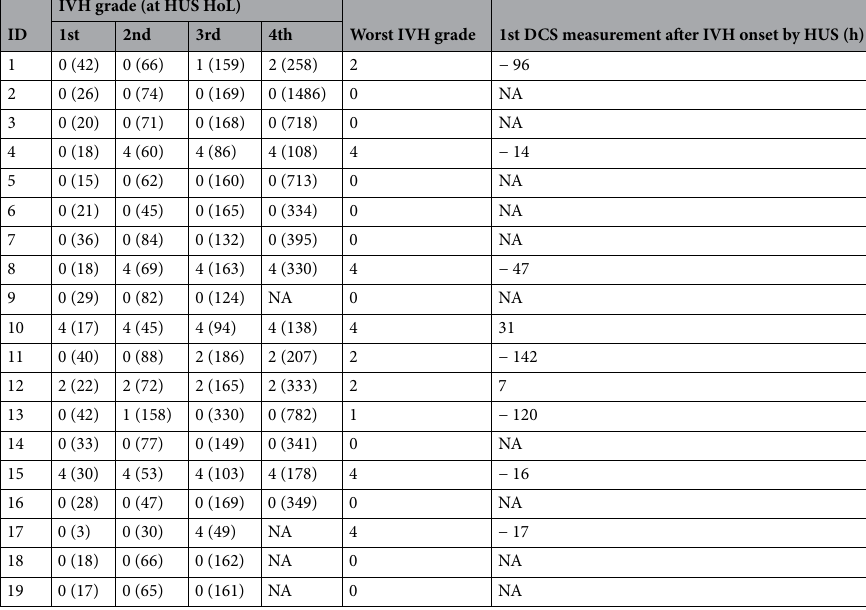
measurement days, three were rejected due to noisy CBF i determined by the beta criteria (2) or due to operator error (1). Each variable listed in Tables 1, 2, and 3 was compared between the three IVH groups. For statistical tests, data transformation was applied as log 10 [median CBF i level], [daily minimum hematocrit, HCT, level] 2 , √ T RiSC , and logit[CV SBFi ] to meet the normality assumption. (See Supplementary Table S1 and S2 for the details of the normality test and transformations applied.) Univariate tests indicated that neither GA nor BW were different between the groups ( P = 0.61 or 0.42, respectively). Apgar scores at 1 and 5 min were significantly lower in the severe-IVH group compared to the no- IVH group (Tukey post-hoc comparison, P = 0.03 and 0.04, respectively). In addition, the mortality rate was the highest in the severe-IVH group ( P = 0.03). Moreover, the average time to IVH onset from birth (determined by head ultrasound, HUS) was significantly earlier in the severe-IVH group than in the mild-IVH group ( P = 0.04). As shown in Table 2, the daily average MAP level trended the highest in the severe-IVH group, although there were only two measurements from one subject in the mild-IVH group ( P = 0.06 for between all groups, P = 0.05 between severe and mild-IVH groups using Tukey post-hoc test). The MAP fluctuation did not differ between the groups, as shown by the CV MAP ( P = 0.42). Administration of medication (i.e., caffeine, indomethacin, inotropes, or acetaminophen) during the measurement was not notably high nor statistically different between the groups. No significant association was found between CBF fluctuation and IVH outcomes. The DCS- based variables and computed indices are shown in Table 3. The average data rejection due to motion artifacts or other external factors was 9.6% in all subjects (7.4, 11.8, and 7.8% in no-, mild-, and severe- IVH groups, respec- tively). As illustrated in Table 3 and Fig. 4, the SBF i levels differed between the three groups ( P = 0.04), showing lower SBF in CBF i fluctuation between the groups (computed by CV CBFi using 5-, 20-, or 40-min windows, P = 0.95, 0.95, or 0.77, respectively). Moreover, when we tested CBF i levels and CBF i fluctuations using the [IVH < 72 HoL Yes/ No] groups, no differences emerged (CBF i levels P = 0.29; CBF i fluctuations using 5-, 20-, or 40-min windows were P = 0.54, 0.63, and 0.50, respectively, between the closed red and open blue circles in Fig. 4). Supplementary Table S3 lists the significant covariates, including Apgar score at 5 min (showed a larger fluctuation with greater Apgar, P Apgar = 0.04), MAP fluctuation (strong positive correlation, P MAP < 0.001), and mode of ventilation (a larger fluctuation with non-invasive modes of ventilation, P ventilation = 0.04), although they did not change the main effect observed between the IVH groups and CBF i fluctuation. A significant interaction was found, show- ing a negative correlation between daily minimum HCT 2 and CBF i fluctuation in the severe-IVH group, while showing a positive correlation between the two variables in the no-IVH and mild-IVH groups ( P IVH*HCT^2 = 0.04, supplementary Table S3). Severe‑IVH showed the highest RiSC compared to other groups. We found an association between RiSC indices and IVH after accounting for birthweight ( P = 0.03, Fig. 5 and Supplementary Fig. S2a). Tukey post-